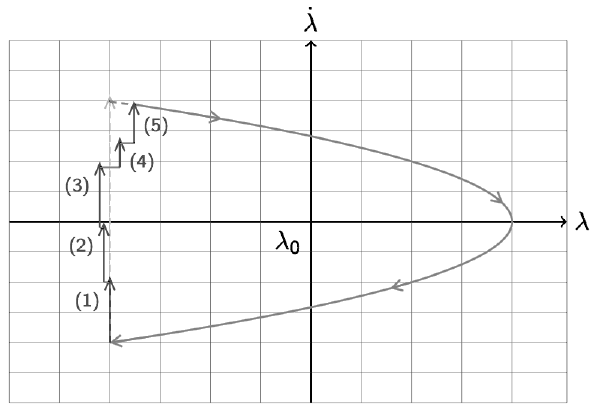
Figure 6. Example of five loops of the operation ring of E–W